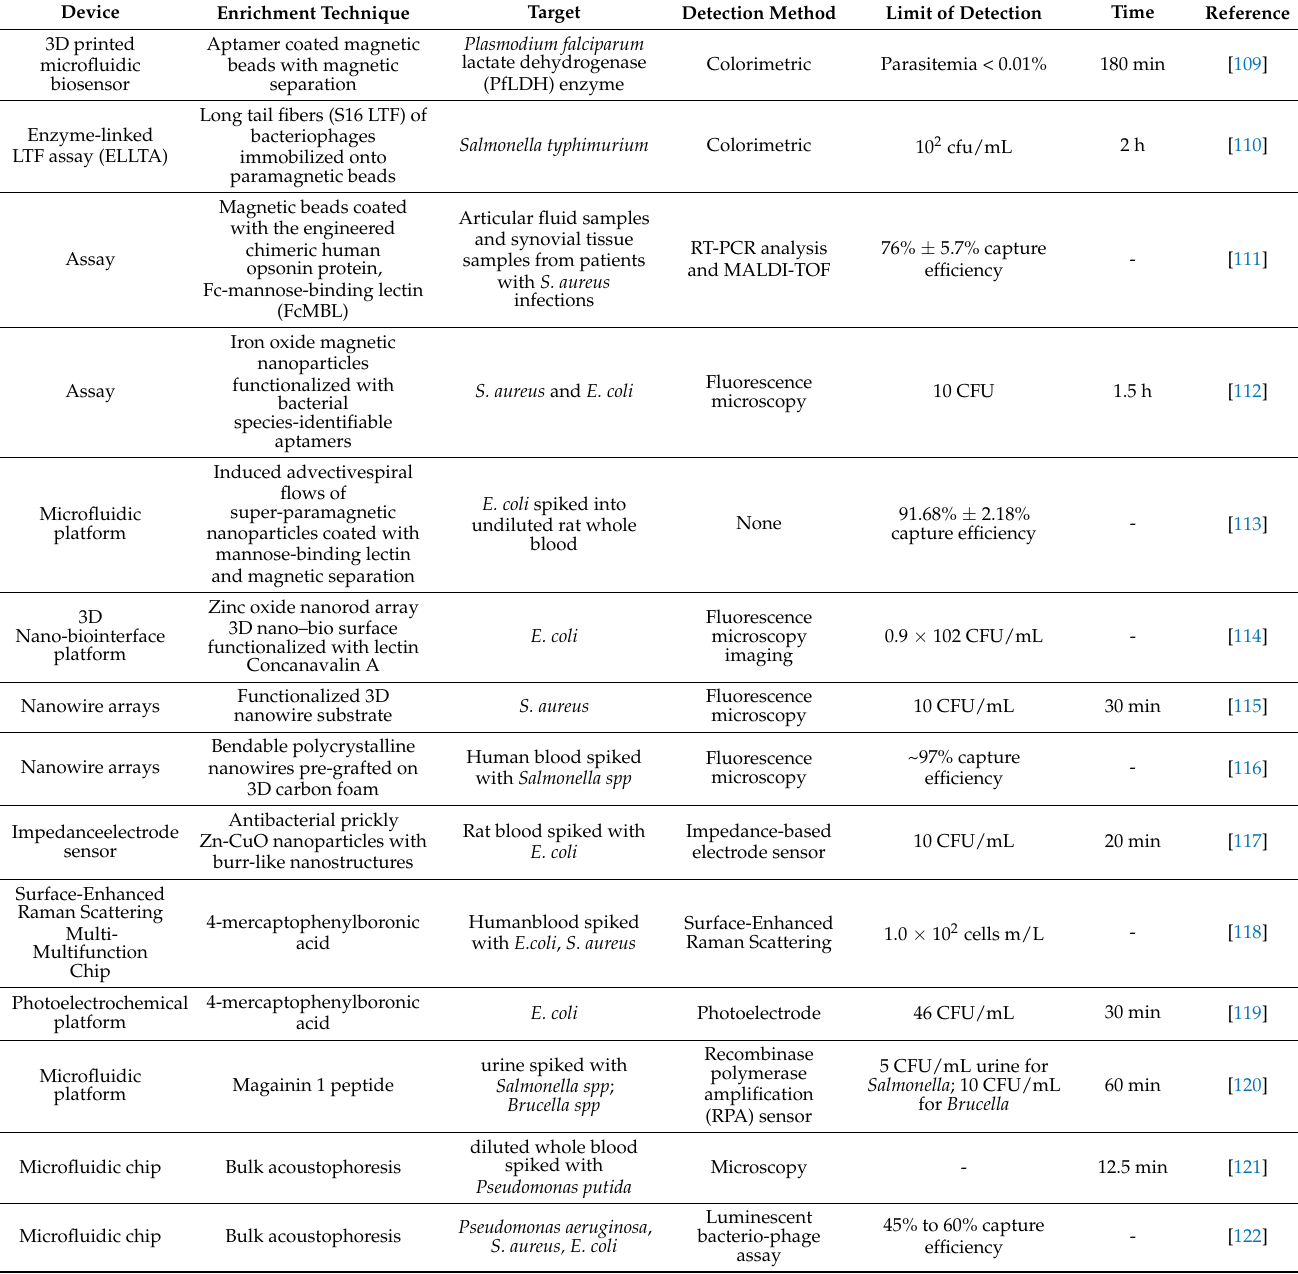
Table 2. Review of pre-analytical target enrichment methods using adhesion receptor interactions to detect infection. Note that samples mostly consisted of artificially spiked materials. Hence, most of the tests target bacteria. The test costs could not be compared, as data were frequently missing. (LPS: Lipo-Poly-Saccharide; LTA: Lipo-Teichoic